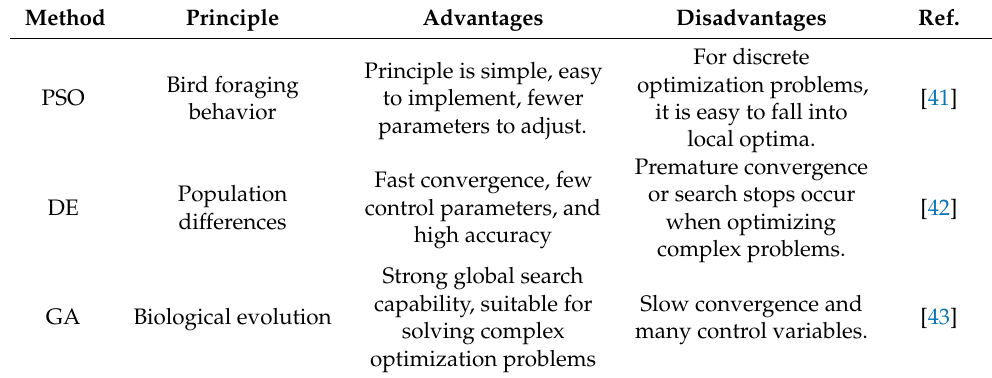
Table 7. Comparison among different multi-parameter optimization algorithms.